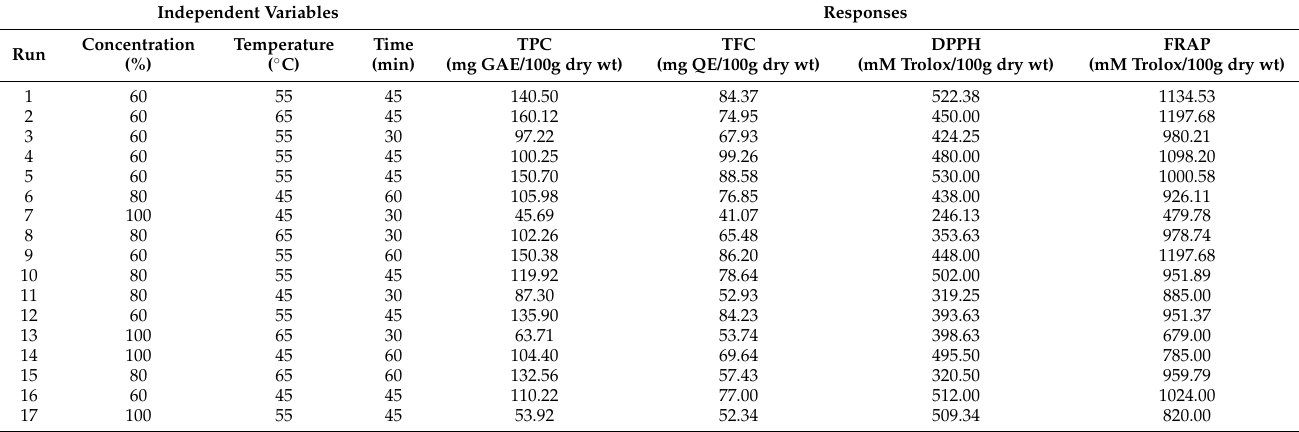
Table 2. The functional properties of cocoa shell powder (CSP) extract under different extraction